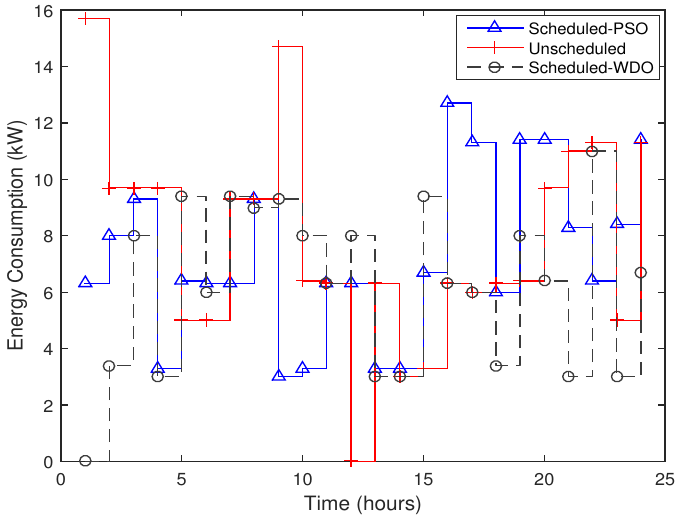
Figure 10. Energy consumption comparison of the PSO and WDO algorithms.